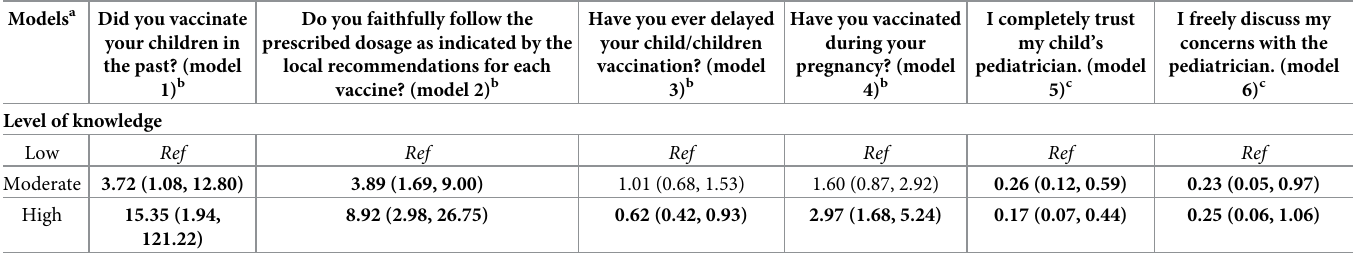
by the local recommendations for each vaccine (Model 2), the delay of vaccination (Model 3), the vaccination during pregnancy (Model 4), the trust to the pediatrician (Model 5), and the discussion with the pediatrician (Model 5) as a linear combination of each question about knowledge of vaccination and the characteristics of the participants (i.e., age of the mother, geographical area, residency, marital, job, educational and income status, single parent family status and number of children). After the evaluation of the statistical significance of the models using Bonferroni correction, the statistically significant associations are presenting in Table 5. Respondents who answered correctly to the questions Q22, Q23, Q25, Q27, Q28 and Q30 are more likely to vaccinate their children compared to those who answered incorrectly ( Model 1 , Table 5). More specifically, people who answered correctly to the question “Systematic vacci- nation helped to reduce or eliminate many infectious diseases worldwide” had 18.58 times higher risk of vaccinating their children compared to participants who answered incorrectly (95% CI: 5.17, 67.05). When we modeled the faithful following of the prescribed dosage as indicated by the local recommendations for each vaccine as a linear combination of each ques- tion about knowledge of vaccination and the characteristics of the study, we reported Table 4. Multiple logistic regression models [(with odds ratios (ORs) and 95% confidence Intervals (CI)] for the association between mothers’ knowledge about vac- cination and vaccination status of children and their mother during pregnancy, mothers’ attitudes to the pediatrician. Models a Did you